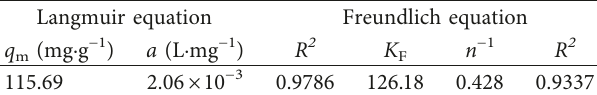
Figure 5: Adsorption isotherm: (a) Langmuir equation; (b) Freundlich equation. Table 5: Adsorption isotherm parameter.